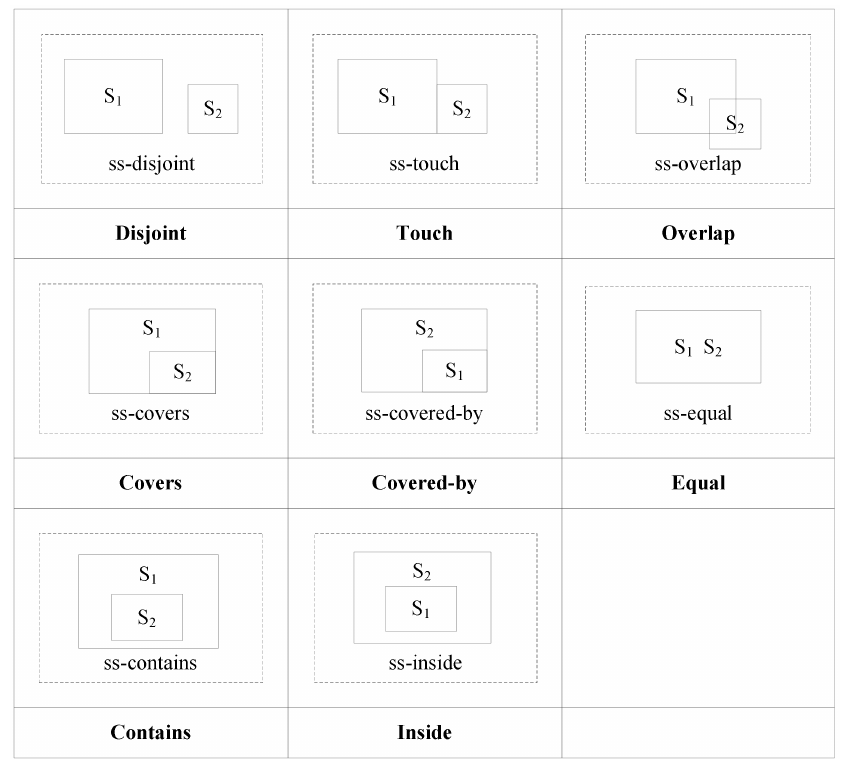
Figure 13. Topological relations between two